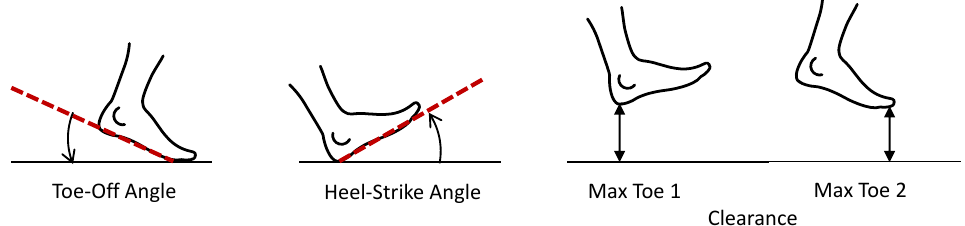
Figure 3. Specific spatial gait parameters: toe-off angle, heel strike angle and